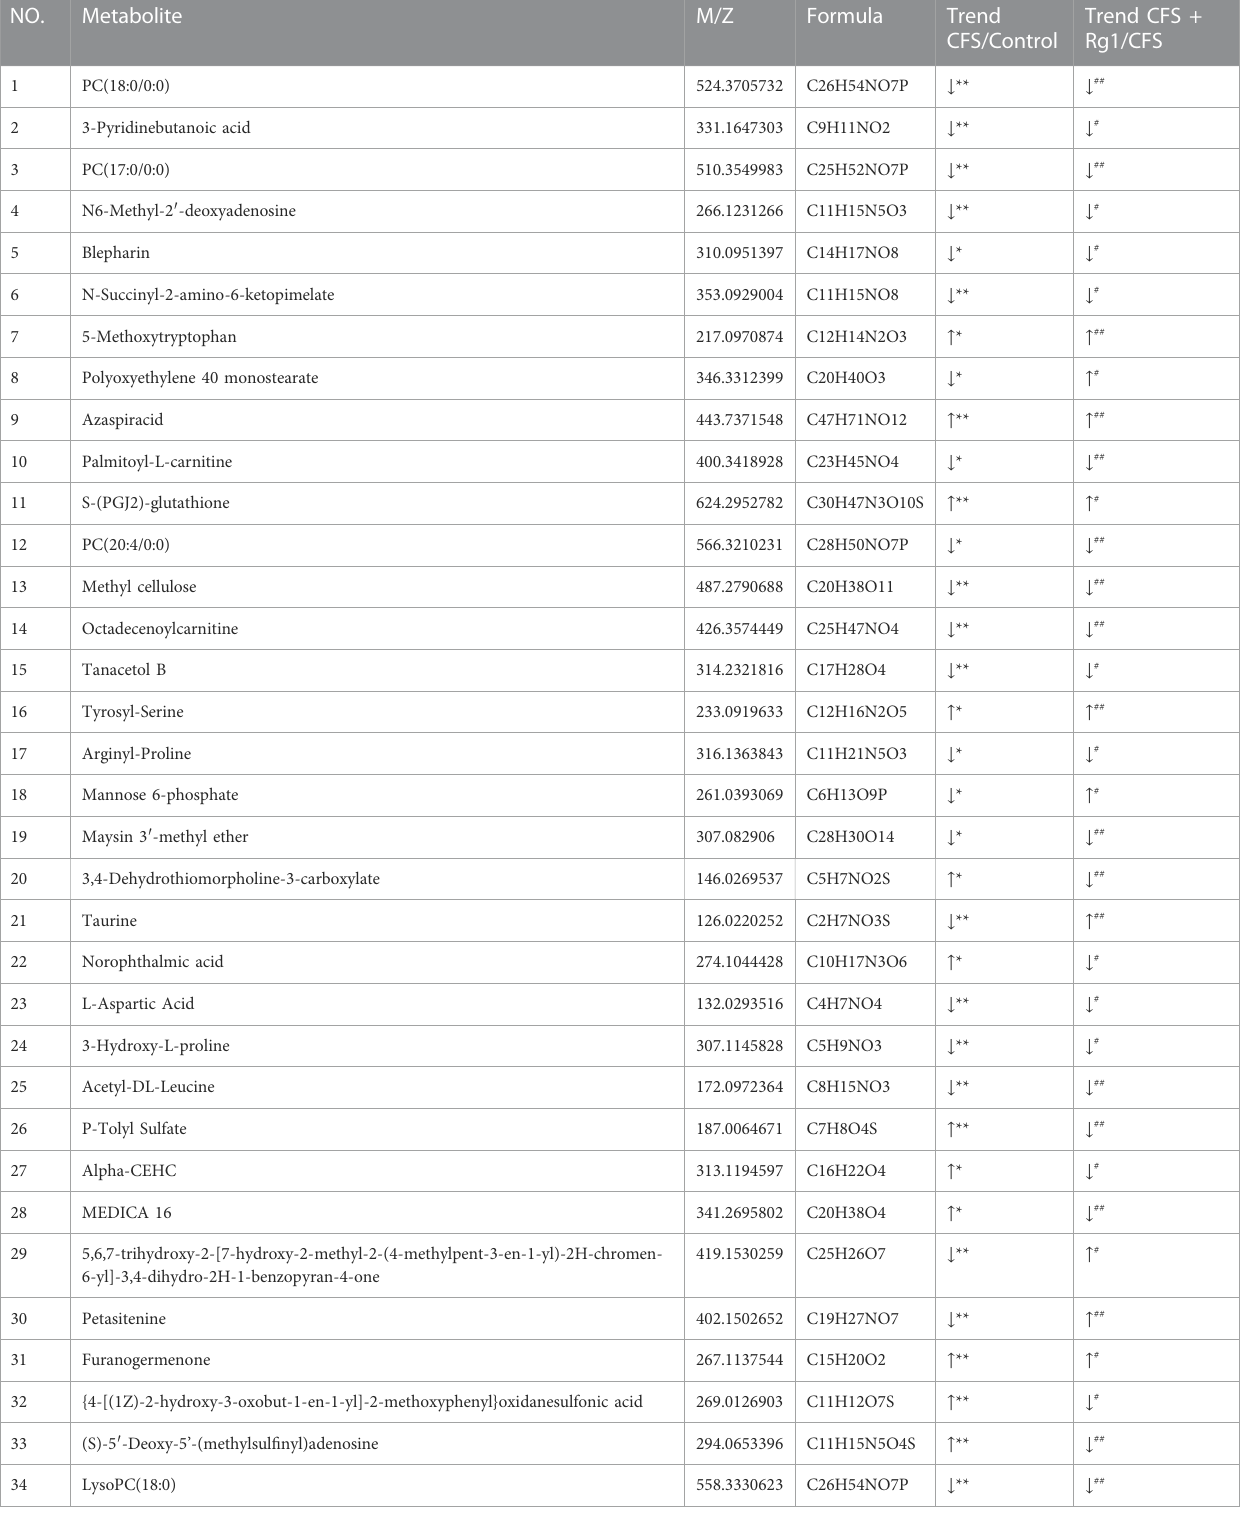
TABLE 2 Differential metabolites associated with ginsenoside Rg1 in serum. NO. Metabolite M/Z Formula Trend